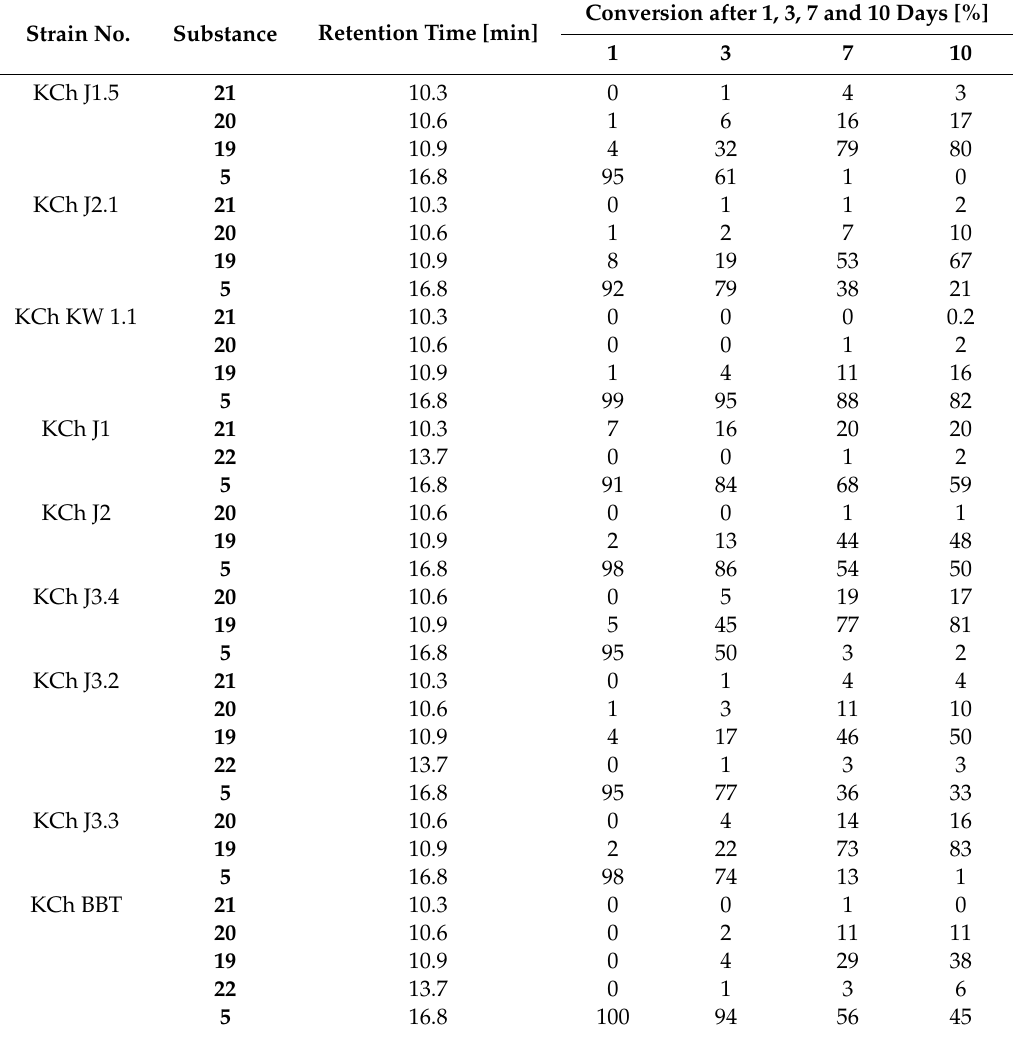
Table 6. Microbial transformation of 3 (cid:48) ,4 (cid:48) ,5 (cid:48) -trimethoxyflavone ( 5 ), HPLC conversion. Strain